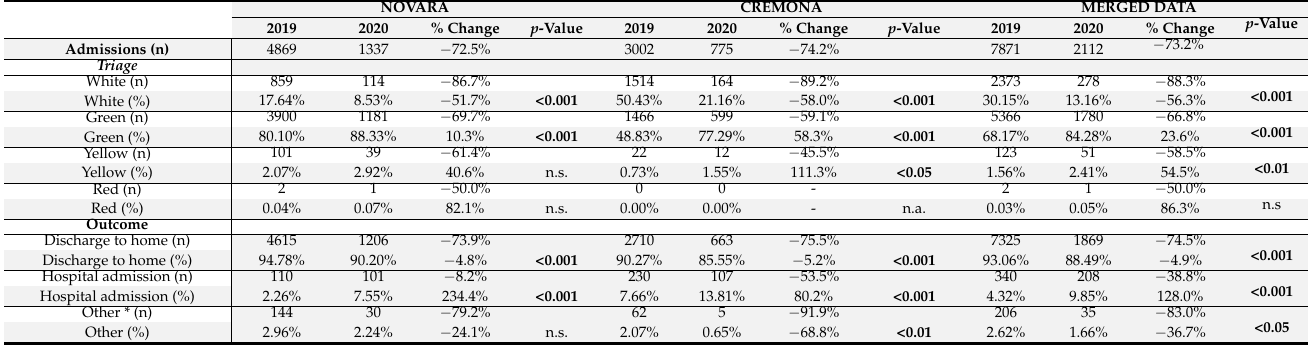
Table 1. Admissions data for children under 15 years of age attending the Cremona and Novara pediatric EDs during the